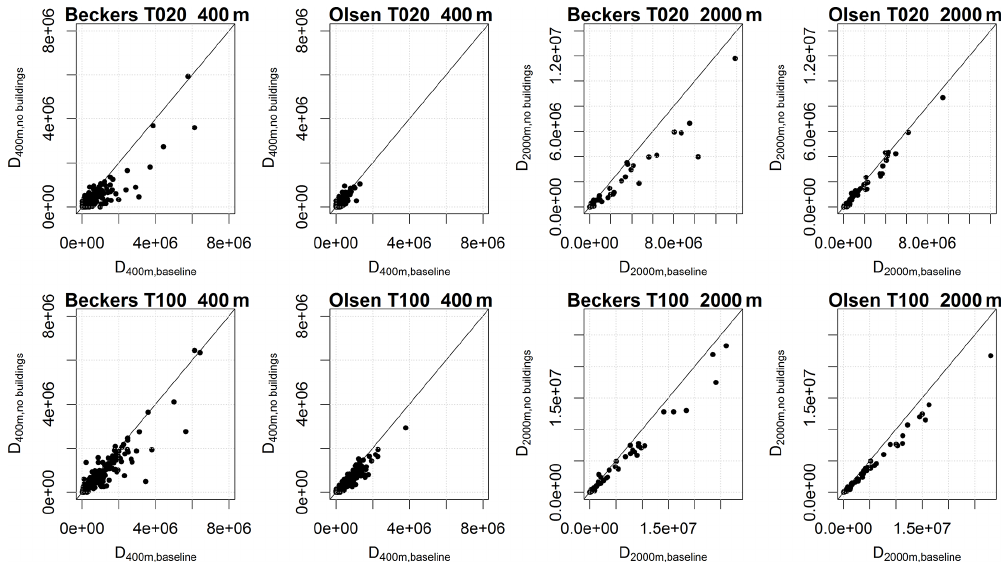
Figure 6. Scatterplots of flood damage estimated based on 2D flood simulations with (baseline) and without buildings included in the DEM. Results are shown for return periods of 20 (top row) and 100 (bottom row) years, for both damage assessment frameworks and for spatial aggregation levels of 400 and 2000m. Damage was assessed by overlaying building polygons and the corresponding flood